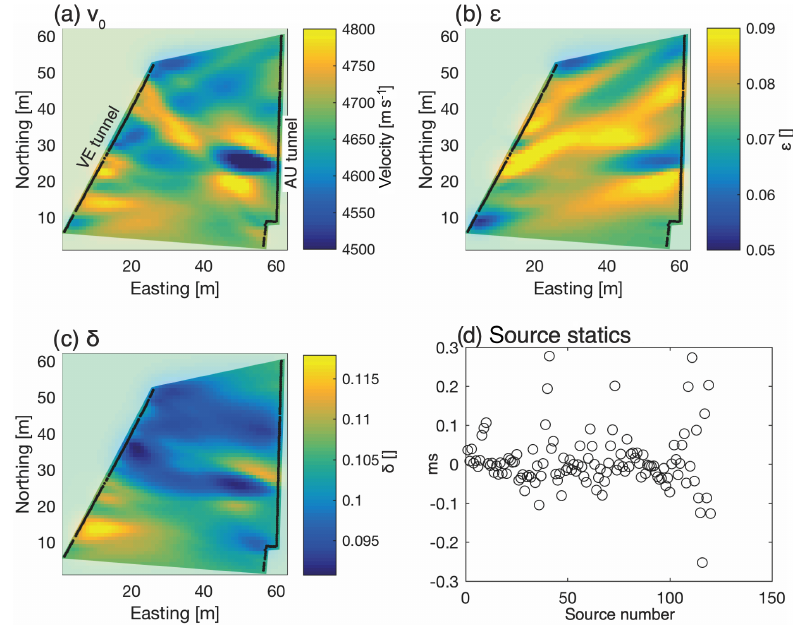
Figure 8. Results of the anisotropic 2-D tunnel–tunnel seismic travel-time tomography. The inversion estimates the three Thomsen (1986) parameters v 0 (a) , (cid:15) (b) and δ (c) along with source statics (d) to account for rock quality differences around the source positions. Sources and receivers are marked as black dots.